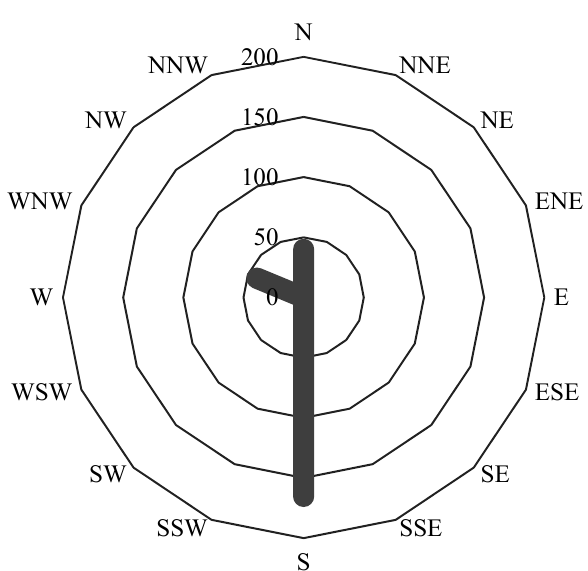
Figure 6. Distribution of radon (Bq/m 3 ) in different directions from the tailings dominated region, which is denoted as the central point on the plot .